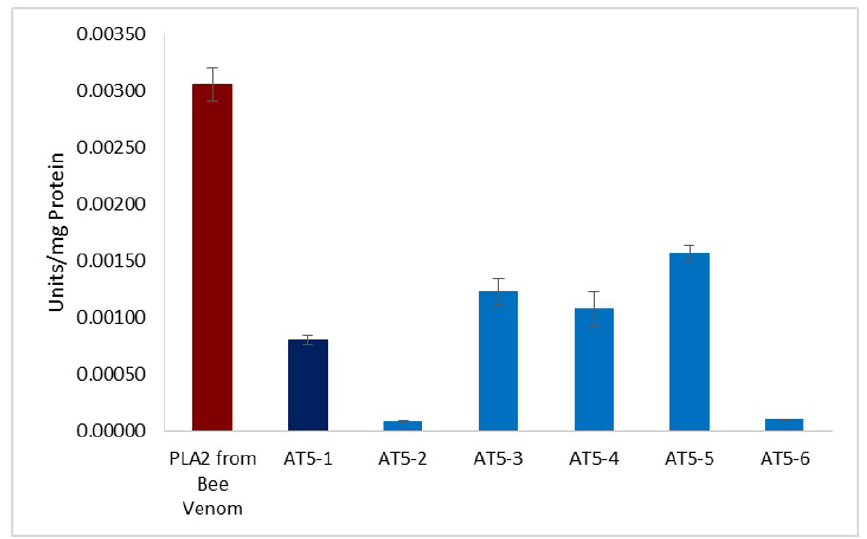
activity of venom fractions from P. bundokalbo . Averaged value from three trials with triplicate readings. Different letters indicate Figure 6. Presence of PLA 2 significant differences (p <